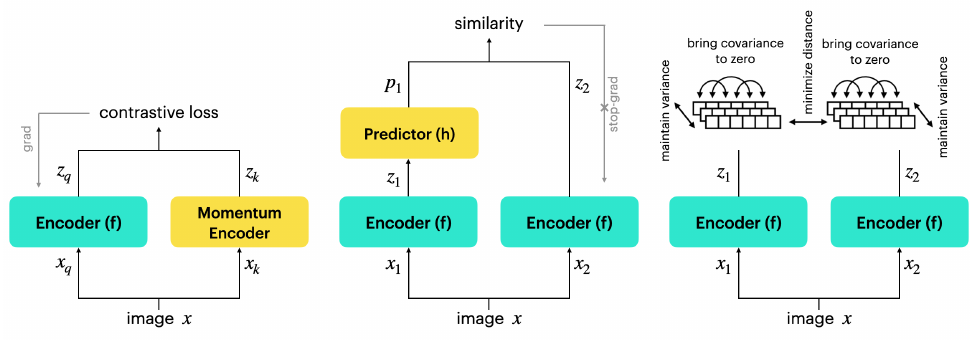
Figure 8. Different self-supervised learning architectures ( x 1 and x 2 stand for different augmentations of image x ): left—MoCo [6]; middle—SimSiam [14]; right—VICReg